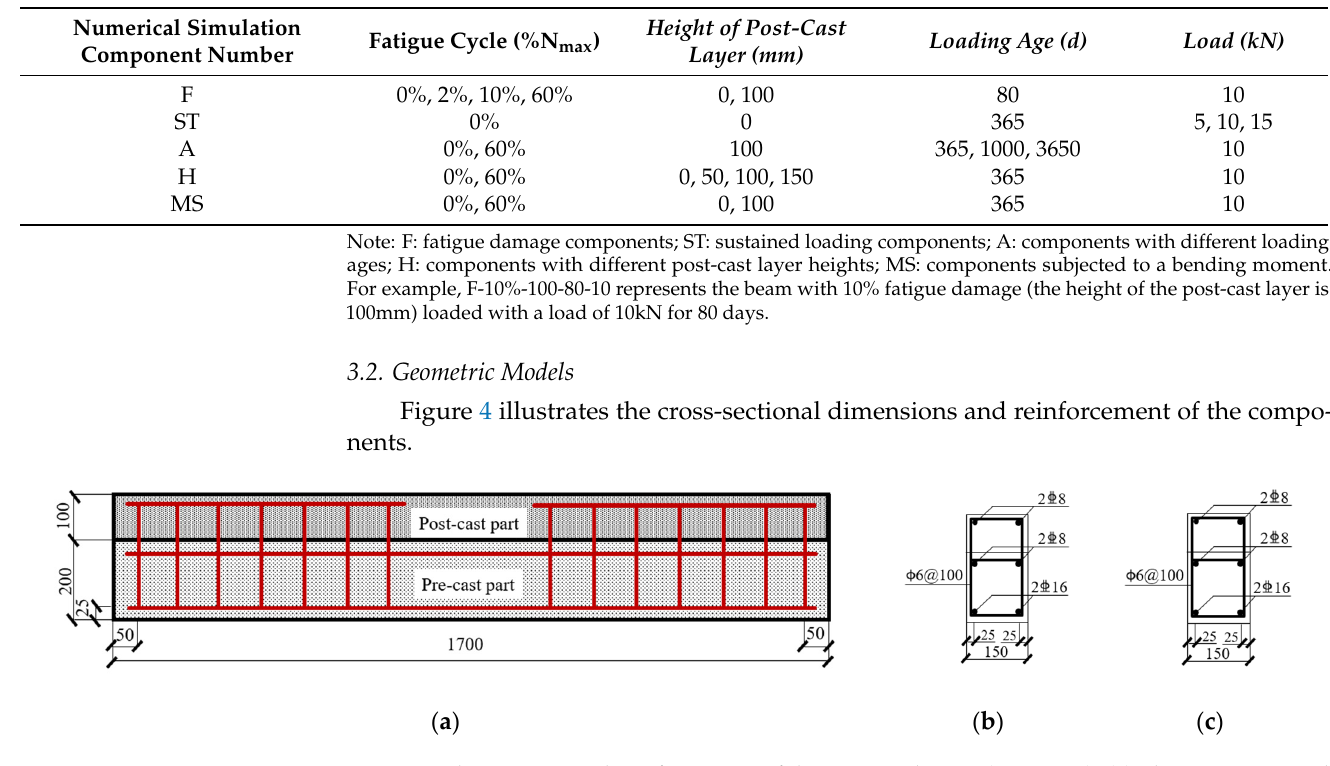
Table 1. The working conditions for the numerical simulation of beams.